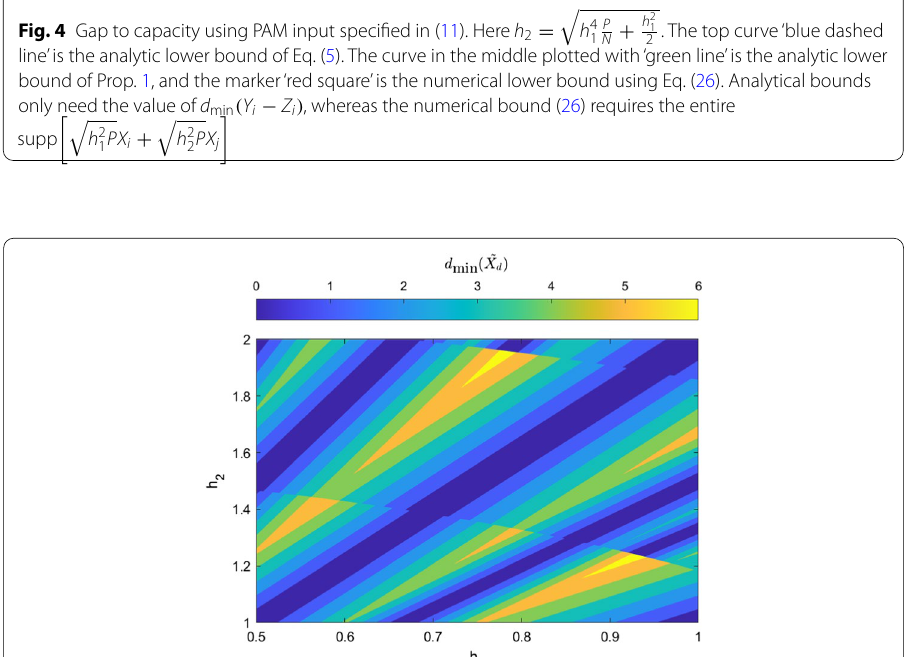
X d as the (cid:31)